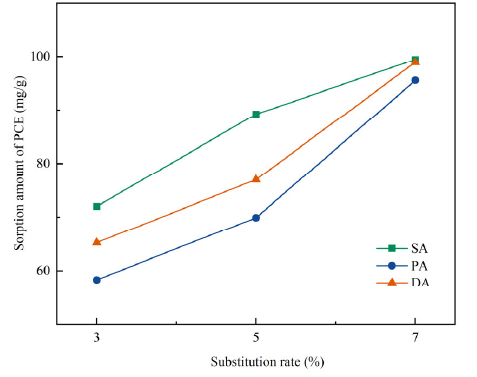
Figure 5. Effect of different separate addition methods on the sorption of PCE in cement with Na ‐ Mmt.